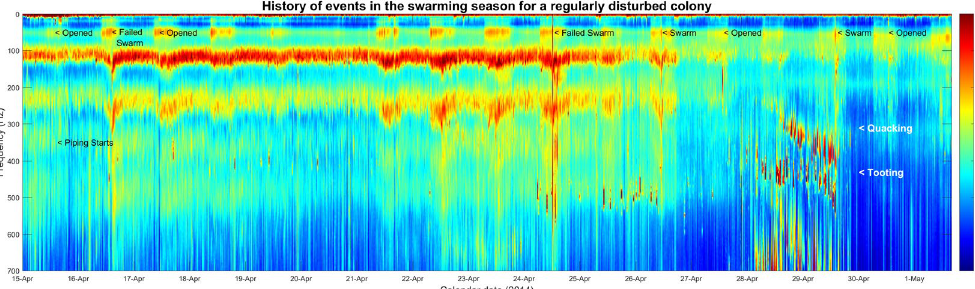
Figure 10. Spectrogram image of 3-minute averaged spectra extracted from the 2014 French colony 14 dataset, showcasing the occurrences of queen piping recorded within a colony that contained a clipped queen and was disturbed throughout its swarming activities between 15 th April and 2 nd May 2014. Midnight of each day begins at each date label on the horizontal axis. Pixel intensity represents logarithmic spectral amplitude from low (blue) to high (red) in arbitrary units. This figure was created using the MATLAB (R2018b) software (uk. mathworks.com).